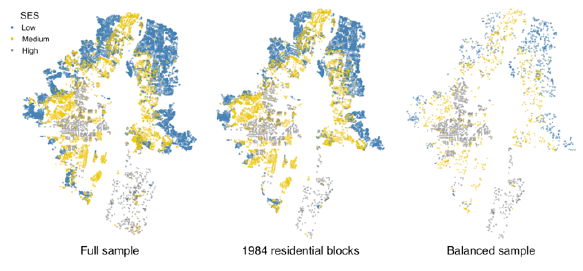
Figure 5. Sample of urban block